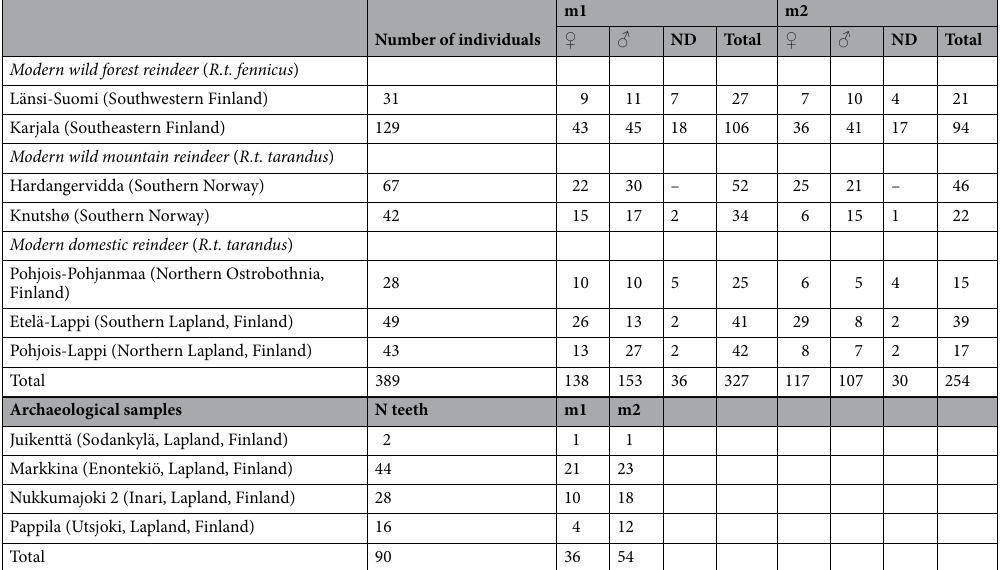
of m1 and m2 was estimated using a new 2D protocol involving nine landmarks and 66 equidistant sliding sem- ilandmarks positioned on the inner edge of the enamel, i.e. at the enamel-dentine junction, to limit biases related to external enamel wear (Fig. 6 and Supplementary Text 4 for more details). The landmark and semi-landmark coordinates were acquired by a single operator (MP) from digital photographs using tpsDig2 v.2.16 73 . Teeth with little to no wear (Class 0) were excluded from the study because tooth wear rendered the landmark protocol inapplicable due to a non-visible enamel-dentin junction or minimal wear with unexposed dentinal connections. Similarly, highly worn (Class 4) teeth were excluded from the analyses, as most individuals had excessively worn teeth for which the protocol was also inapplicable due to the total or partial disappearance of the enamel-dentin junction. Particularly for m2, Class 3 was also excluded due to an insufficient number of individuals (n = 16). Unlike landmarks, semilandmarks do not have an exact anatomical correspondence along the enamel-dentine junction, and instead ‘slide’ along the line between adjacent points in order to minimise the bending energy of the thin-plate spline interpolation function 74 . All specimens’ coordinates were aligned using the Generalized